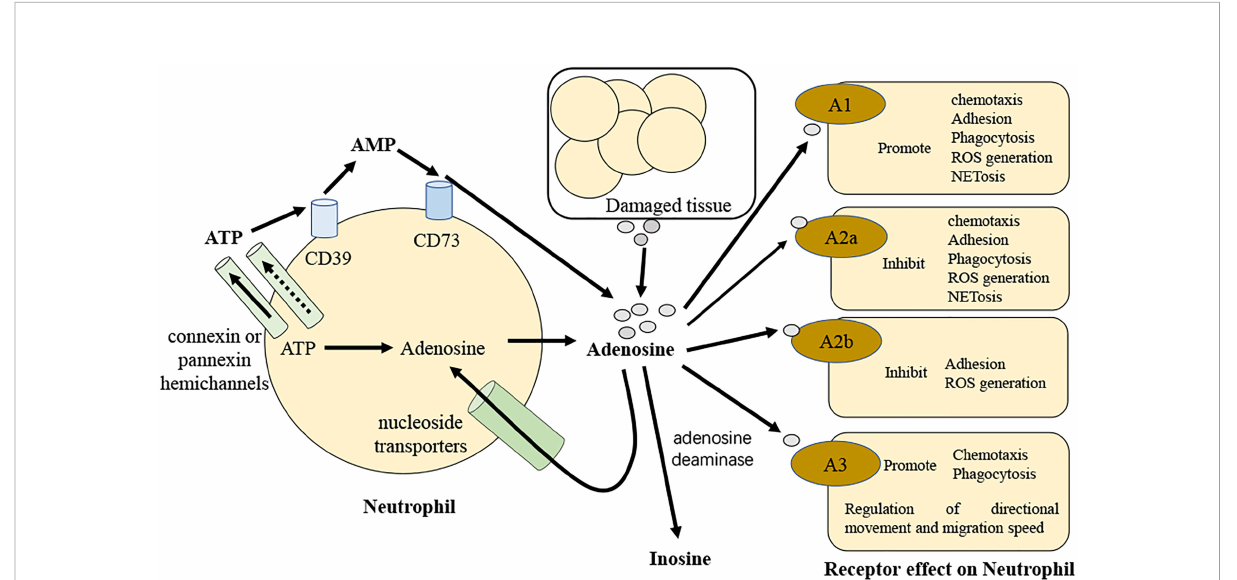
FIGURE 2 Diagrammatic over view of adenosine regulation of neutrophils in sepsis. Adenosine and its precursors are released by activated neutrophils. These precursors can be degraded to adenosine so that they may then operate autocrine to control neutrophil activity. Along with adenosine, neutrophils release ATP in response to stimulation via connexin or pannexin hemichannels and this is promptly degraded to adenosine by the neutrophil surface-expressed ectoenzymes CD39 and CD73. In sepsis, neutrophils and adenosine talk to each other by binding to G protein- coupled receptors A1, A2a, A2b, and